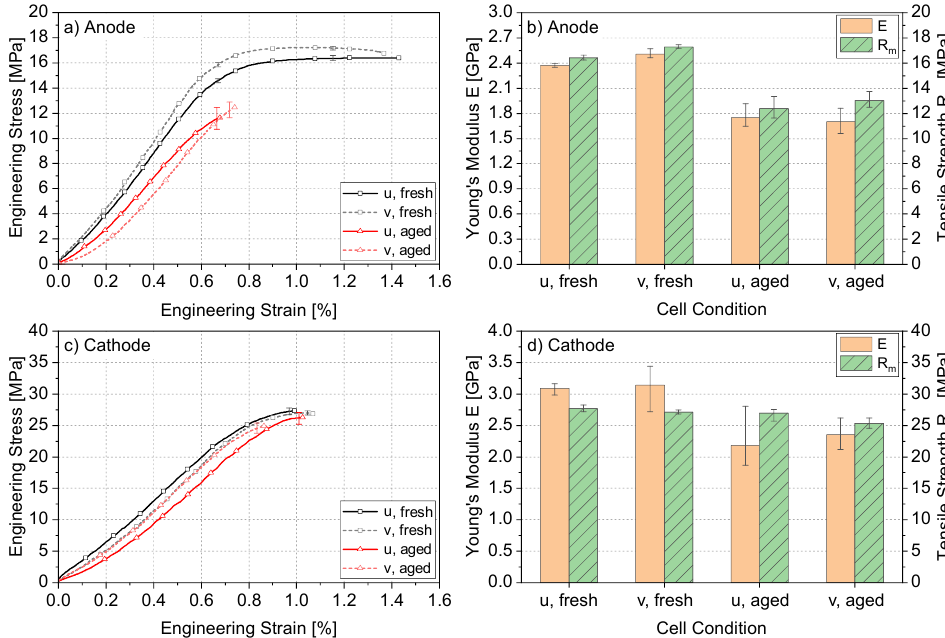
Figure 3. Mechanical test results under tension for fresh and electrically aged anode (Cu–graphite) and cathode (Al–NCM) materials in different cell directions: ( a ) Shows the anode’s stress–strain curves and ( b ) the anode’s Young’s modulus and tensile strength. Analogously, the results of the cathode are shown in ( c , d